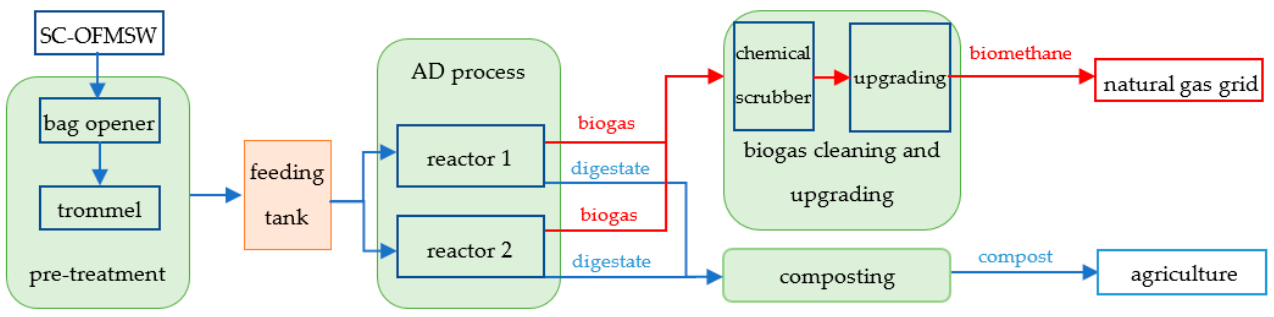
Figure 1. Schematic diagram of Rende AD plant.